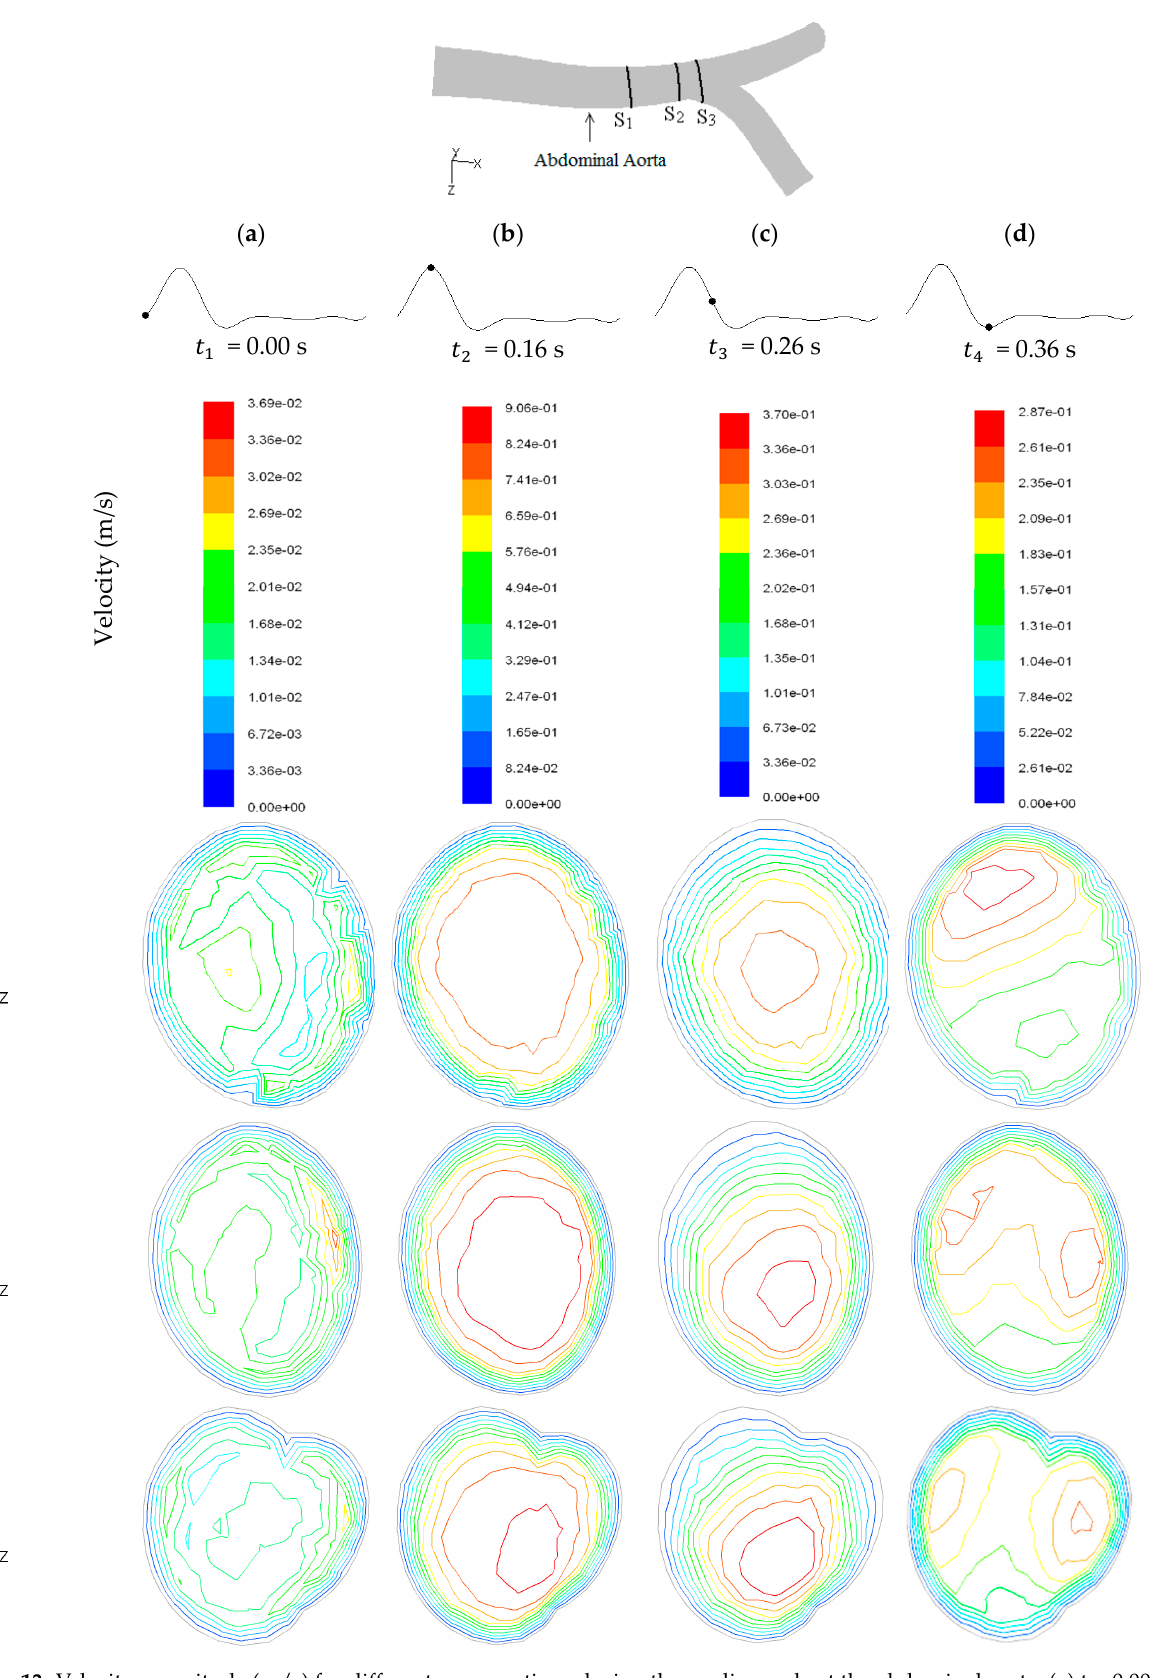
Figure 13. Velocity magnitude (m/s) for different cross-sections during the cardiac cycle at the abdominal aorta, ( a ) t = 0.00 s, ( b ) t = 0.16 s, ( c ) t = 0.26 s, ( d ) t = 0.36 s.